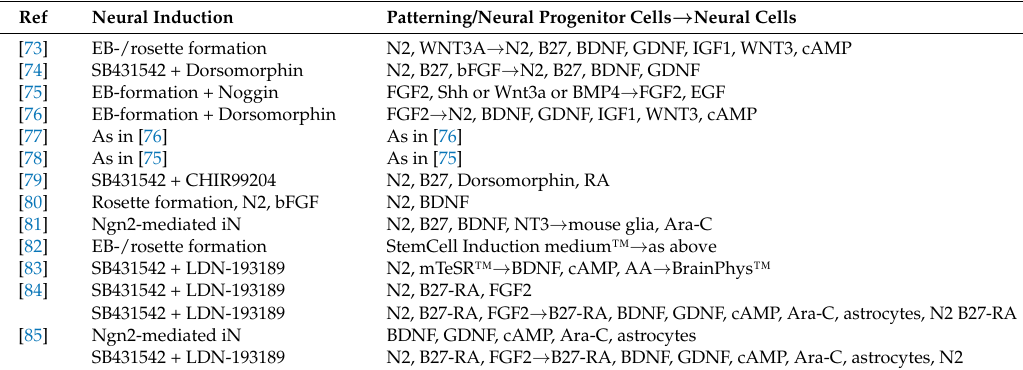
Table 4. Major differentiation